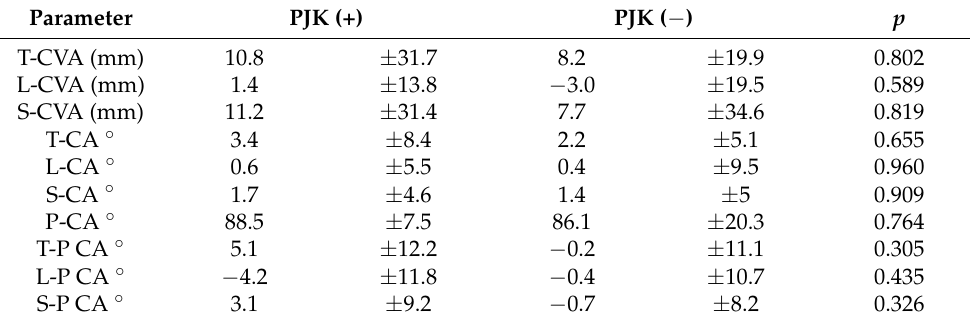
Table 5. Dynamic coronal parameters between each